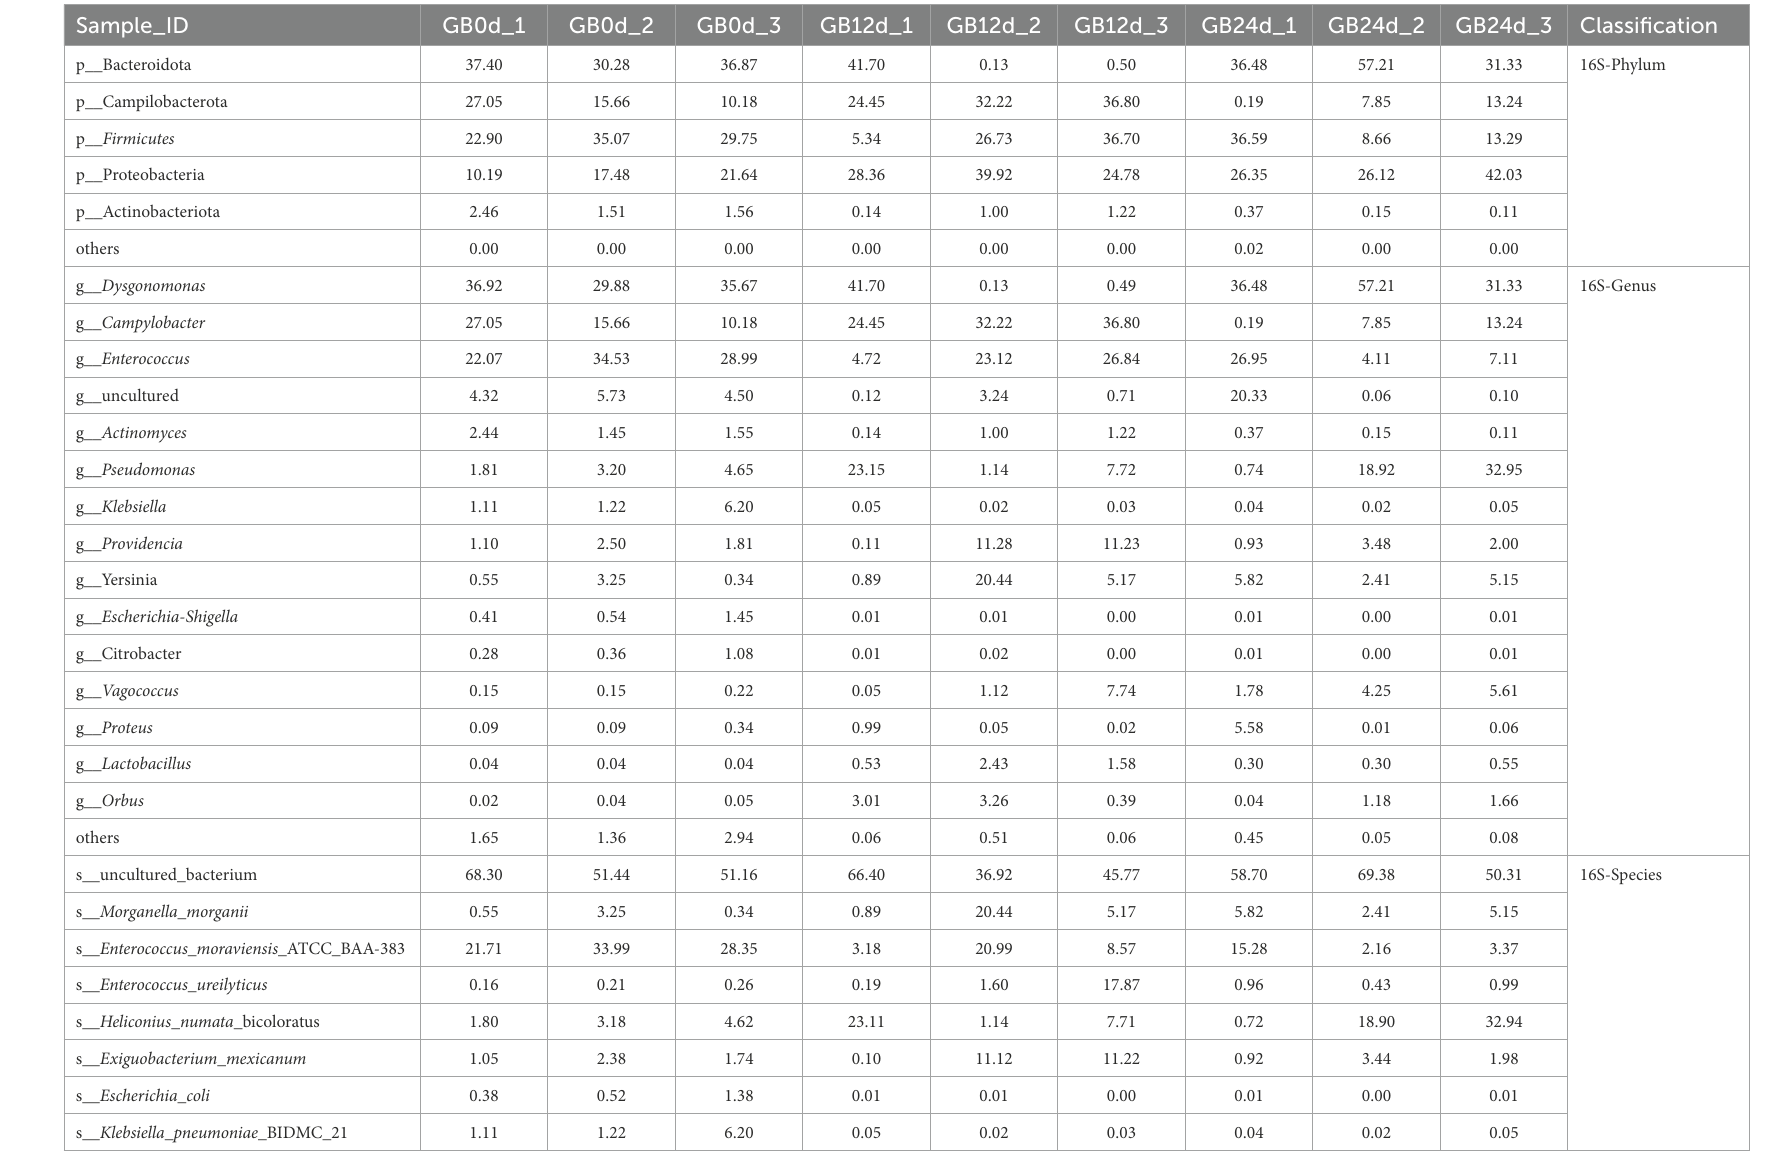
TABLE 8 Relative abundance of